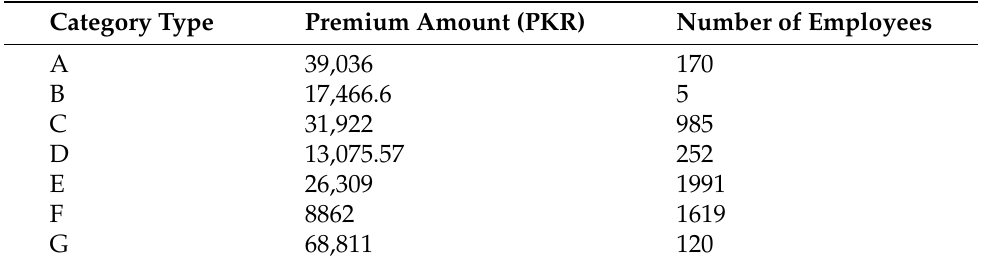
Table 4. Category wise Annual Premium amount and number of employees.